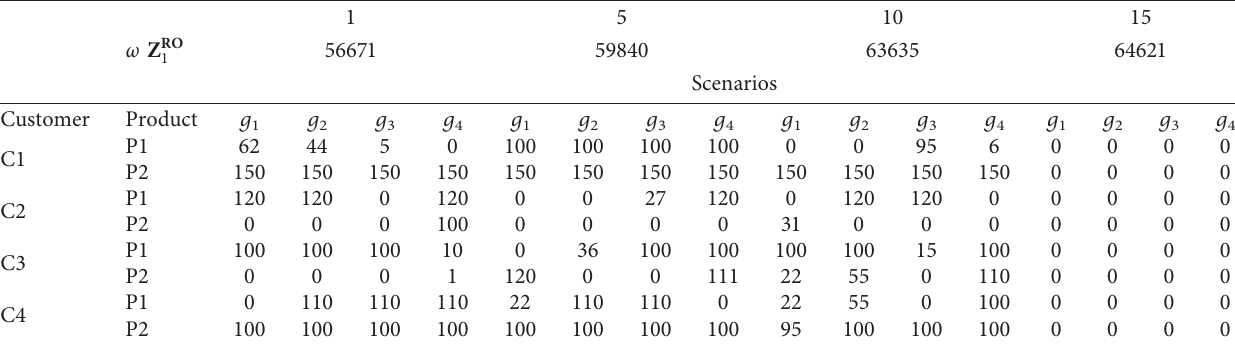
Table 11: Effect of different amounts of ( ω ) on objective function and deviation of